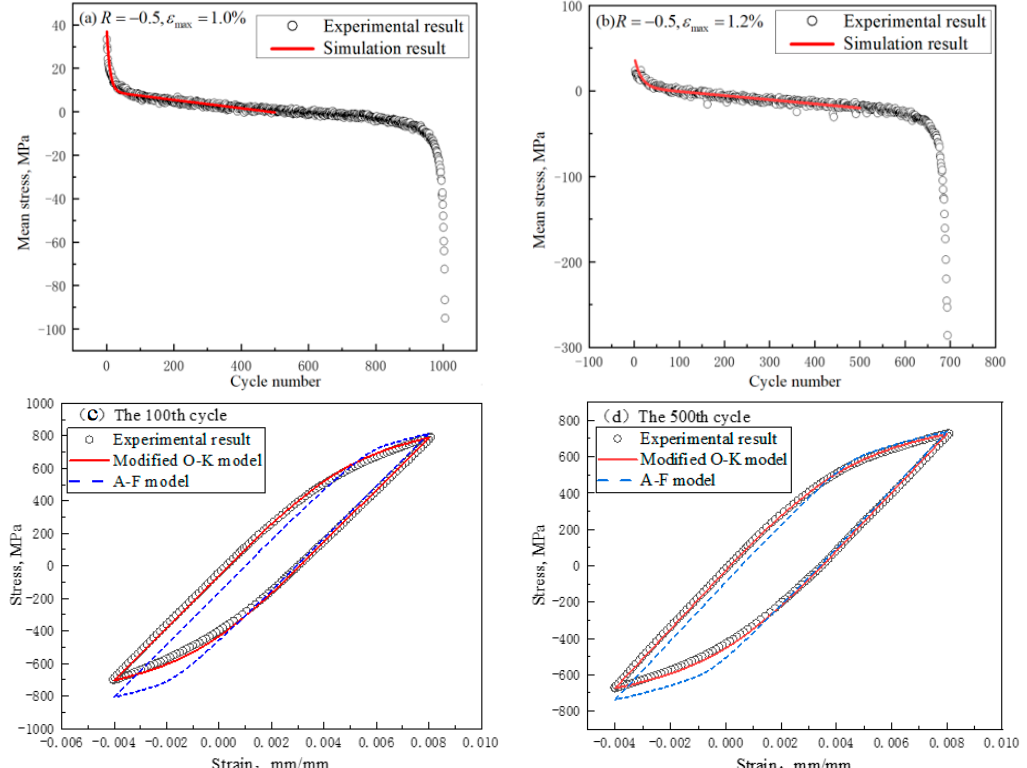
Figure 18. Comparison of stress relaxation behavior between tests and simulations: ( a ) ε max = 1.0%; ( b ) ε max = 1.2%; ( c ) the 100th cycle; ( d ) the 500th cycle.